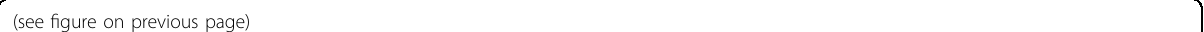
Fig. 1 Most of Δ 113p53 expresses in the radial glial cells and a small part in RMS cells along the telencephalon ventricular zone. A Top panel: a s chematic diagram representing zebra fi sh brain structure. The dotted lines with different numbers represent different positions in the zebra fi sh telencephalon along the anterior to the posterior axis. Gray color: olfactory bulb; green color: telencephalon; purple color: midbrain; red color: hindbrain. Bottom panel: diagram representing the cross-section of telencephalon corresponding to the position as indicated by the dotted line 2 in the top panel. TV telencephalic ventricle, D dorsal telencephalic area, V ventral telencephalic area, Vd dorsal nucleus of V, Vv ventral nucleus of V, RMS rostral migratory stream. The photos in the following panels were representatives of the cross-sections corresponding to the region shown in the diagram. The representatives of other regions were presented in Supplementary Fig. S1. B Cryosections of Tg( Δ 113p53:GFP) telencephalon were immunostained by anti-GFP (in green) ( B ’ ) and anti-p53 (in red) antibodies ( B ” ). The nuclei were stained with DAPI (in blue). Arrowhead: p53 + /GFP − cells; yellow arrow: p53 - /GFP + cells; white arrow: p53 + /GFP + cells. Scale bar, 10 μ m. C Cryosections of Tg( Δ 113p53:GFP) telencephalon were immunostained by anti-GFP (in green) and anti-GFAP (in red) antibodies. The nuclei were stained with DAPI (in blue). The framed area in C was magni fi ed in C ’ (merged), C ” (GFP), and C ”’ (GFAP). Scale bar in C , 50 μ m; Scale bar in C ’ , C ” , C ”’ , 10 μ m. D Cryosections of Tg( Δ 113p53:GFP;olig2:dsRed) telencephalon were immunostained by anti-GFP (in green), and the red fl uorescence was from the en vivo DsRed. The nuclei were stained with DAPI (in blue). The framed area in D was magni fi ed in D ’ (merged), D ” (GFP), and D ”’ (DsRed). White arrows: GFP + /DsRed + cells. Scale bar in D , 50 μ m; scale bar in D ’ , D ” , D ”’ , 10 μ m. E , F Cryosections of Tg( Δ 113p53:GFP);p53 + / + telencephalon ( E , E ’ ) and Tg( Δ 113p53:GFP);p53 M214K/ M214K telencephalon ( F , F ’ ) were immunostained by anti-GFP (in green) and anti-GFAP (in red) antibodies. The nuclei were stained with DAPI (in blue). Scale bar, 10 μ